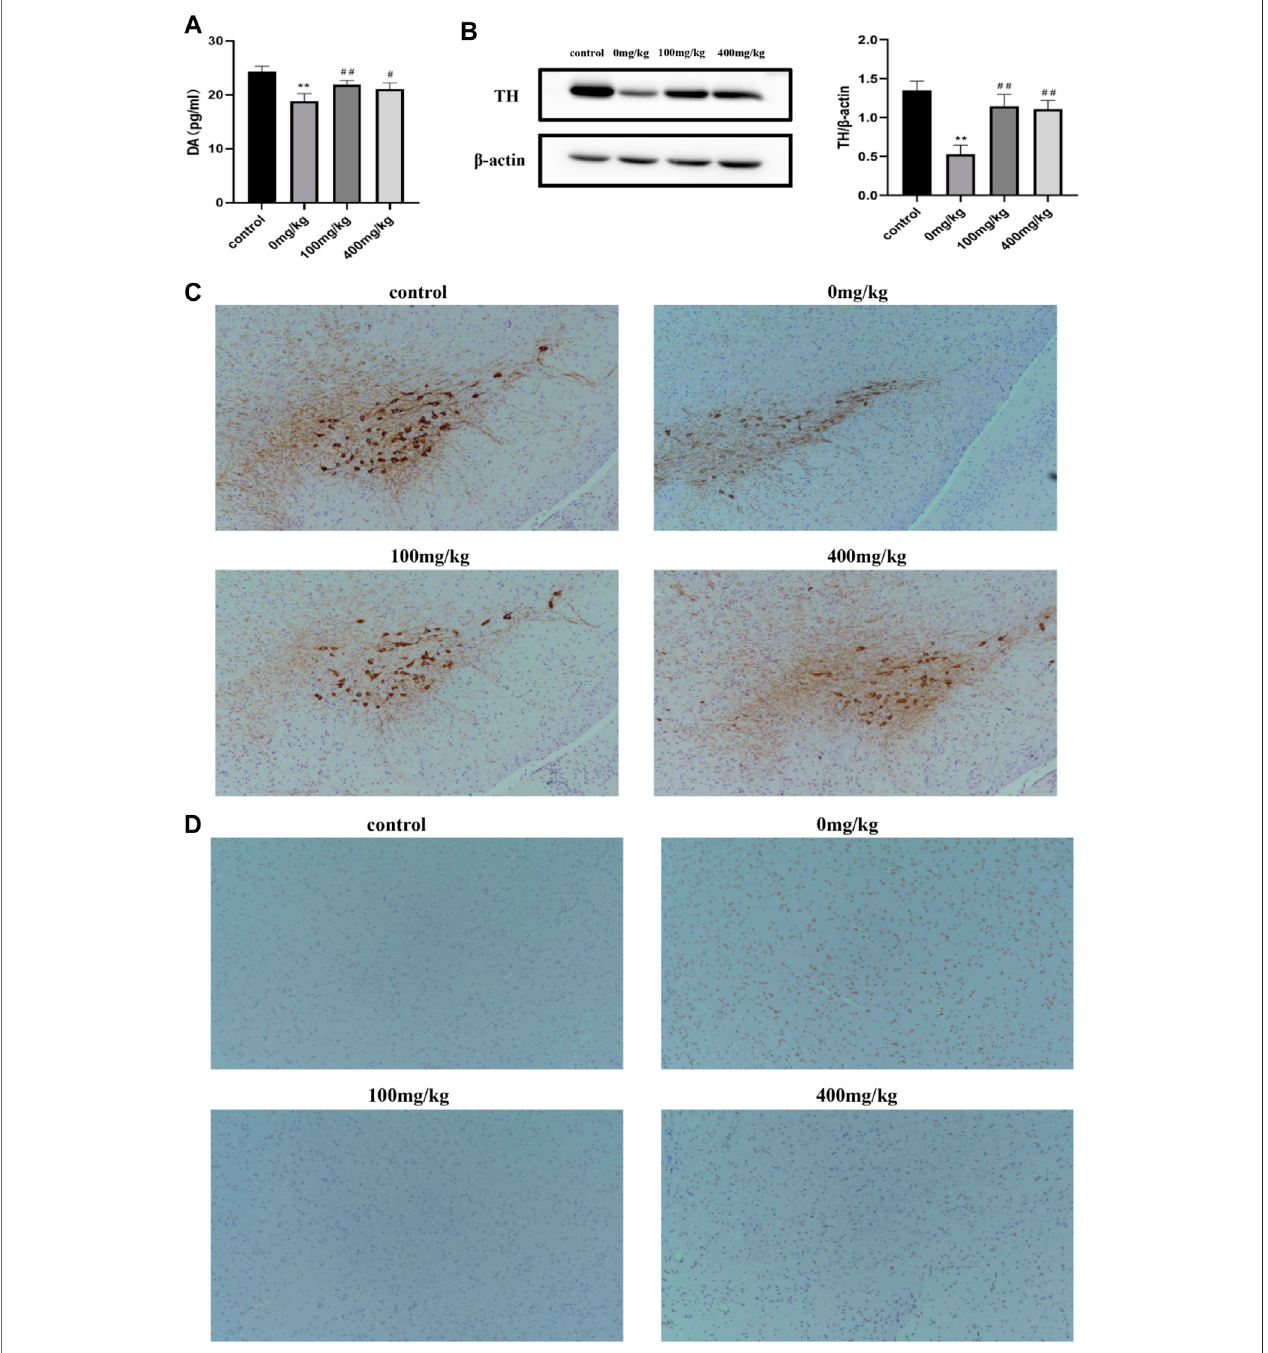
FIGURE 4 | Effects of OPA on striatum and substantia nigra of MPTP-induced PD model mice. (A) the contents of striatal DA in PD model mice were quanti fi ed by ELISA( n =6,mean±SD); (B) theproteinlevelsofstriatalTHweremeasuredbywesternblot.Thedensityofthebandswasnormalizedwiththatof β -actin( n =6,mean± SD); (C) the number of TH-positive cells in the SN was quantitatively analyzed by immunohistochemistry ( n = 4, mean ± SD); (D) the levels of apoptotic neurons were detected by TUNEL assay. Brown indicated the apoptotic cells ( n = 4, mean ± SD). ** p < 0.01 compared with control mice injected saline; # p < 0.05, ## p < 0.01 compared with MPTP-treated